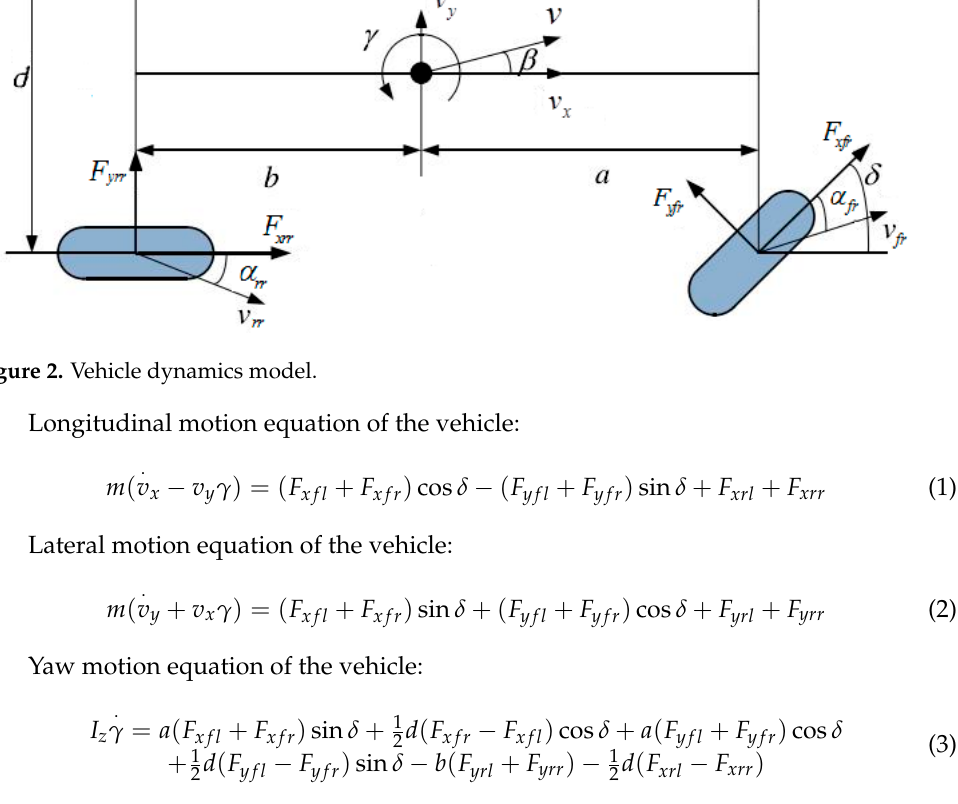
where m is the vehicle mass; a and b are the distances from the vehicle's center of mass to the front and rear axles, respectively; d is the wheel pitch; gitudinal speed, lateral speed and yaw rate of the vehicle, respective- F and F are the longitudinal forces of the left front wheel, right front F , F , ly; xrl xrr xfl xfr wheel, left rear wheel and right rear wheel, respectively; lateral force of the left front wheel, right front wheel, left rear wheel and right rear wheel of the vehicle, respectively.